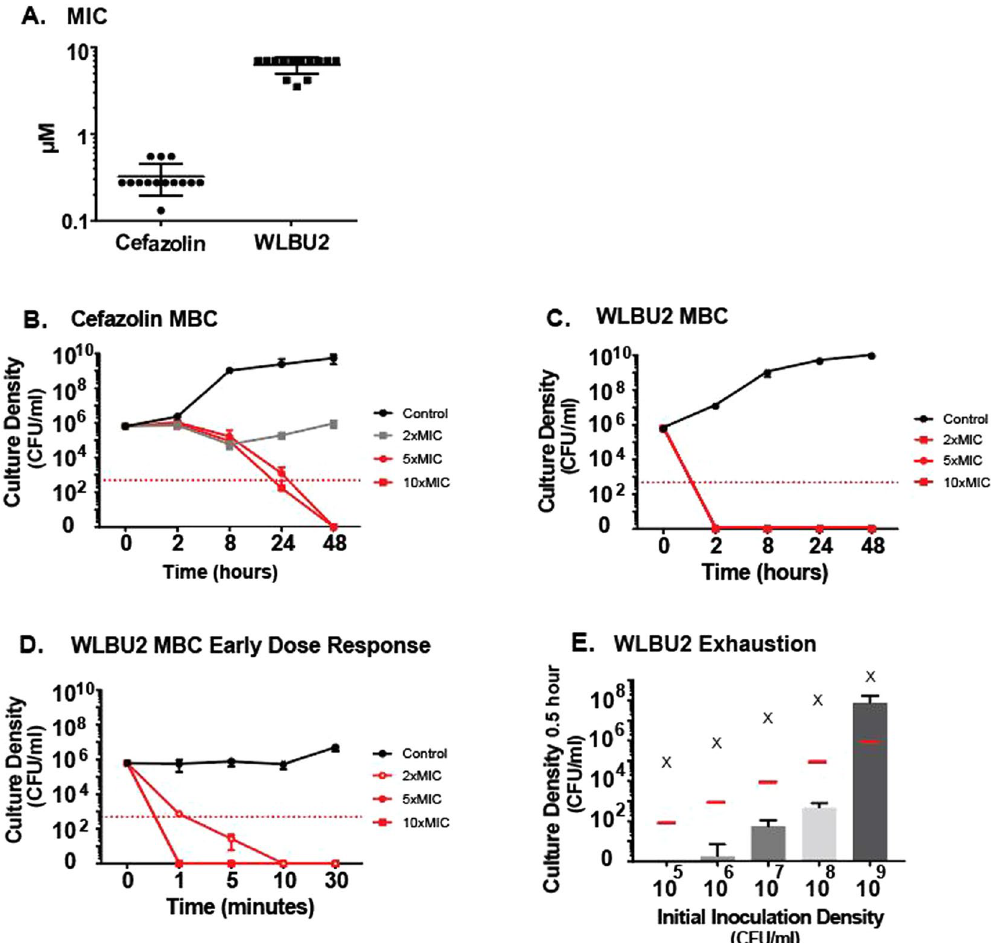
Figure 1. ( A – E ) Antimicrobial activity of cefazolin and WLBU2 against planktonic methicillin-sensitive S. aureus (SH1000). ( A ) Minimum inhibitory concentration (MIC) of cefazolin and WLBU2 determined by serial dilutions of antibiotics added to SH1000 plated at 0.5 × 10 6 CFU and overnight culture turbidity. ( B ) Minimum bactericidal concentration (MBC) of cefazolin determined by CFU drop assays at select time points after addition of antibiotic, red dashed line represents 99.9% drop in live bacteria. ( C ) Initial attempt at WLBU2 MBC quantification based on cefazolin temporal progression, antimicrobial peptide yielded sterile conditions. ( D ) CFU analysis on WLBU2 treated samples within 30 minutes after treatment, showing dose response of killing. ( E ) 10xMIC of WLBU2 added to log fold dilutions of SH1000 including overnight stock inoculum (10 9 CFU/ml) and CFU analysis performed after 30 minutes, WLBU2 at this kills over 99.9% of SH1000 up to 10 8